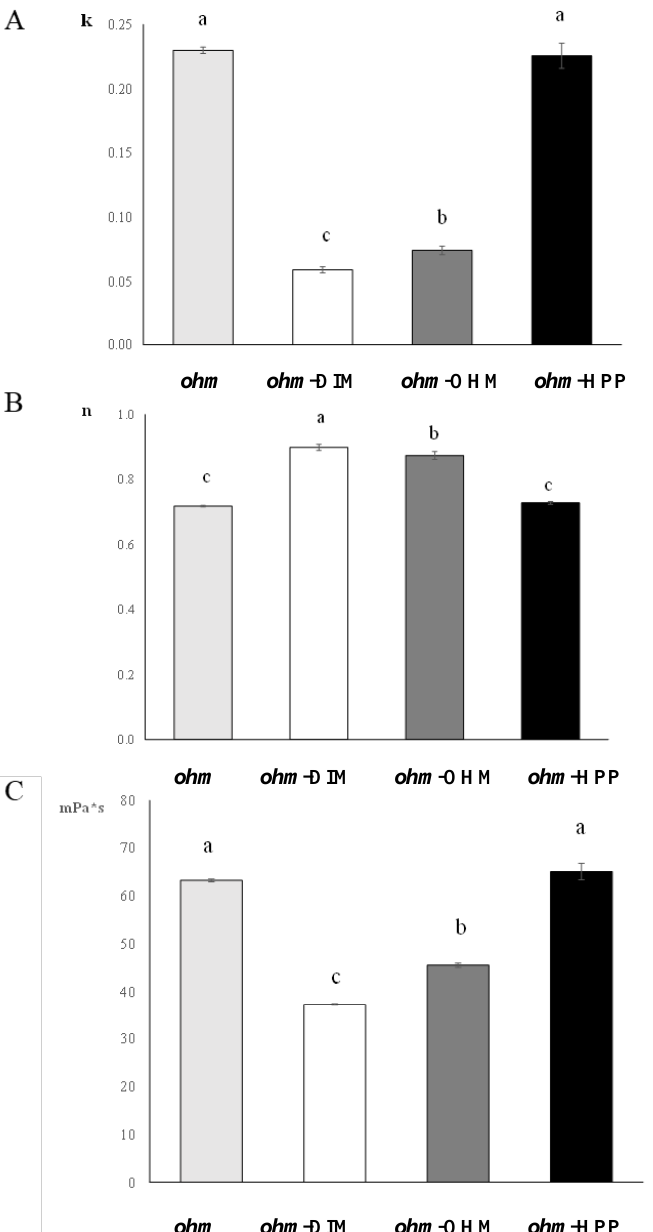
Figure 3. Consistency index (panel A ), flow behavior index (panel B ) and viscosity at 100 s −1 (panel C ) of sugar syrup. a,b,c Same letters do not significantly differ ( n = 3; p < 0.05).